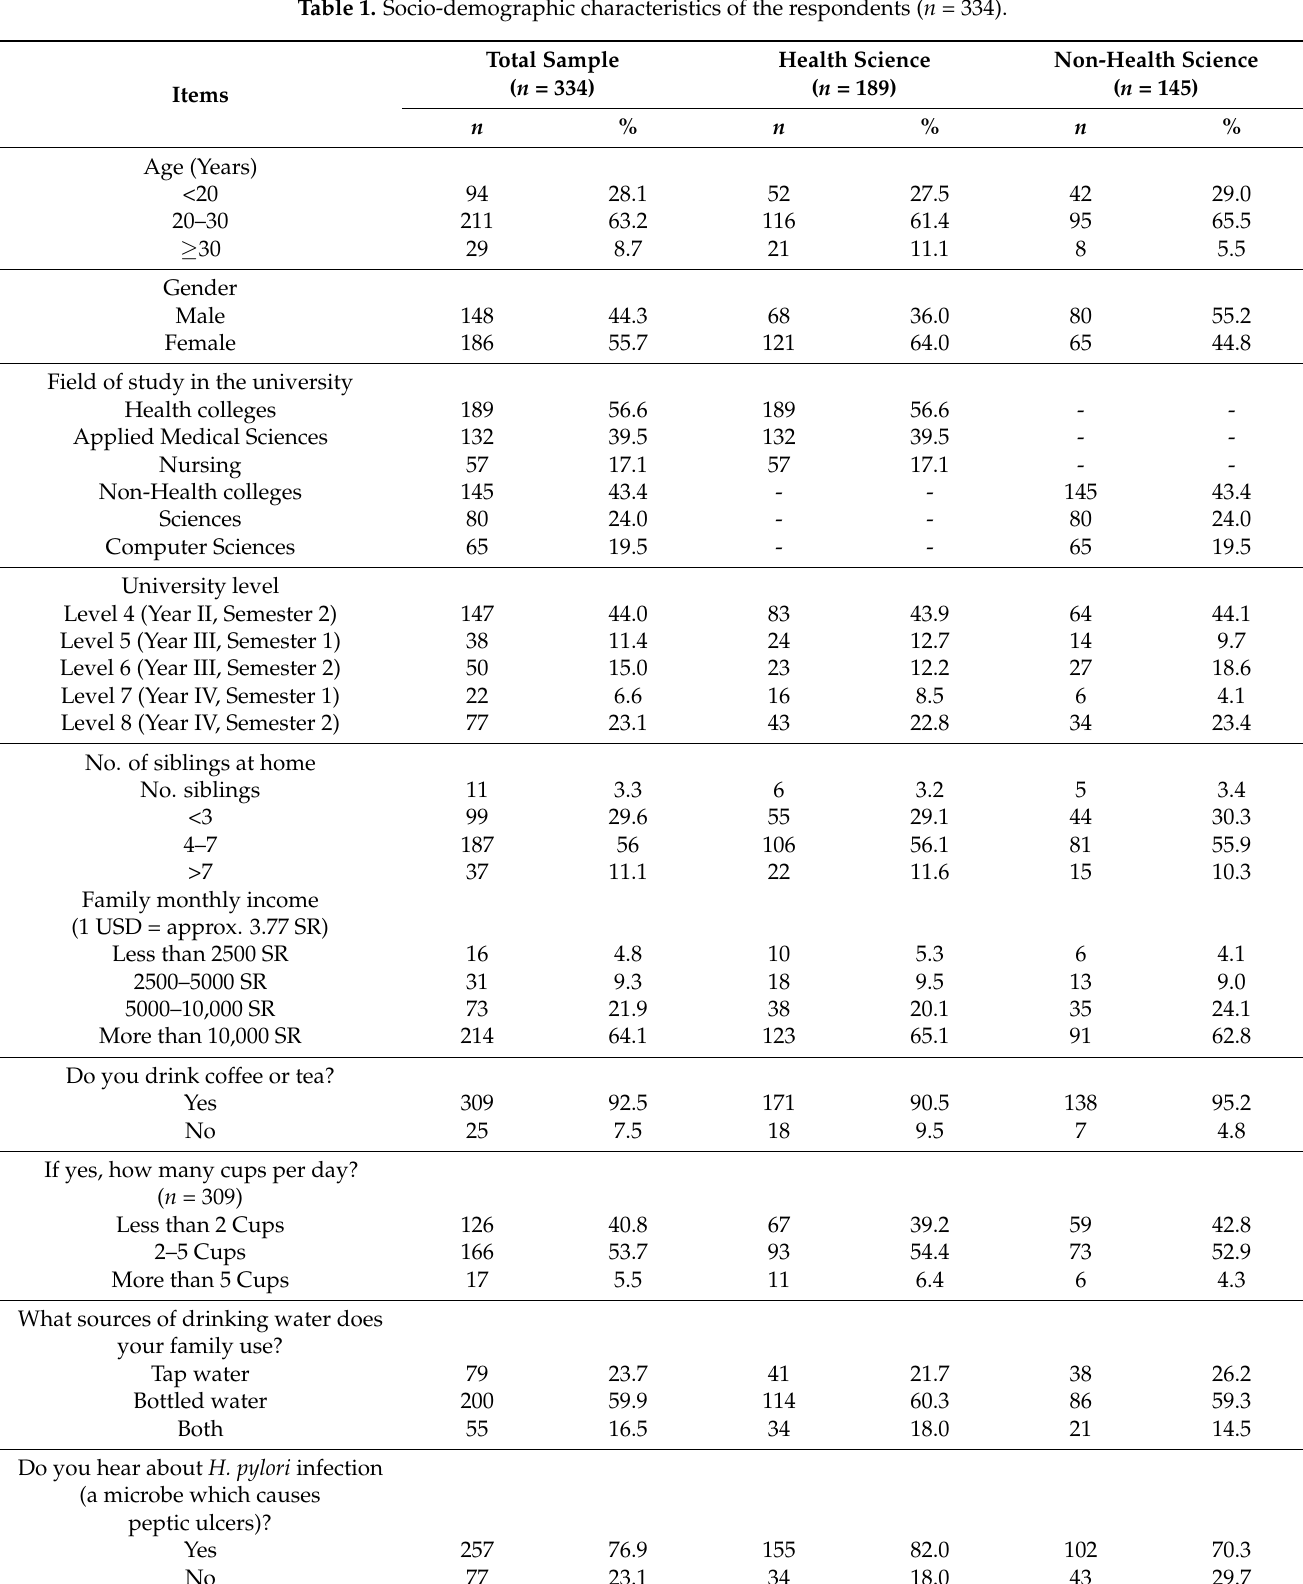
Table 1. Socio-demographic characteristics of the respondents ( n =